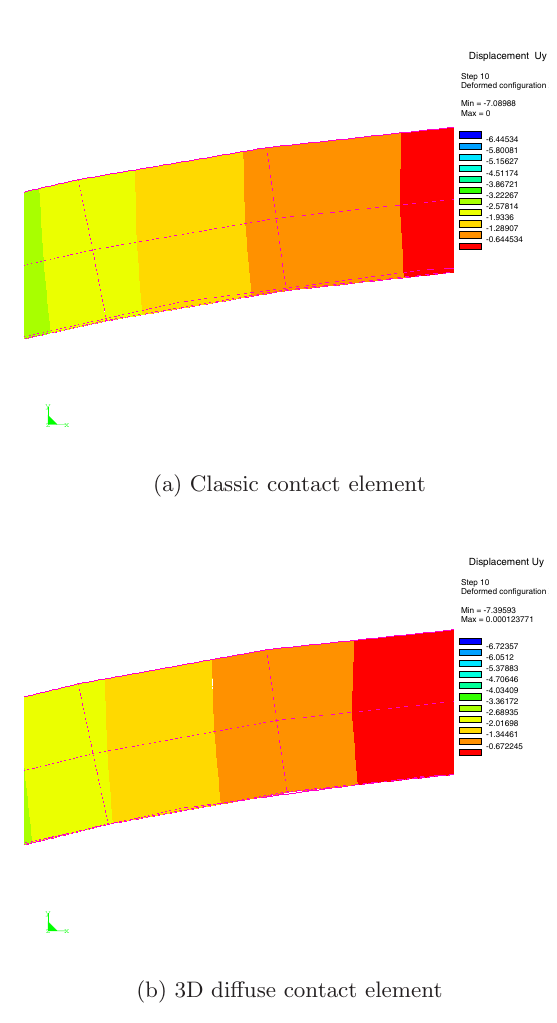
Fig. 14. Zoom in deformed